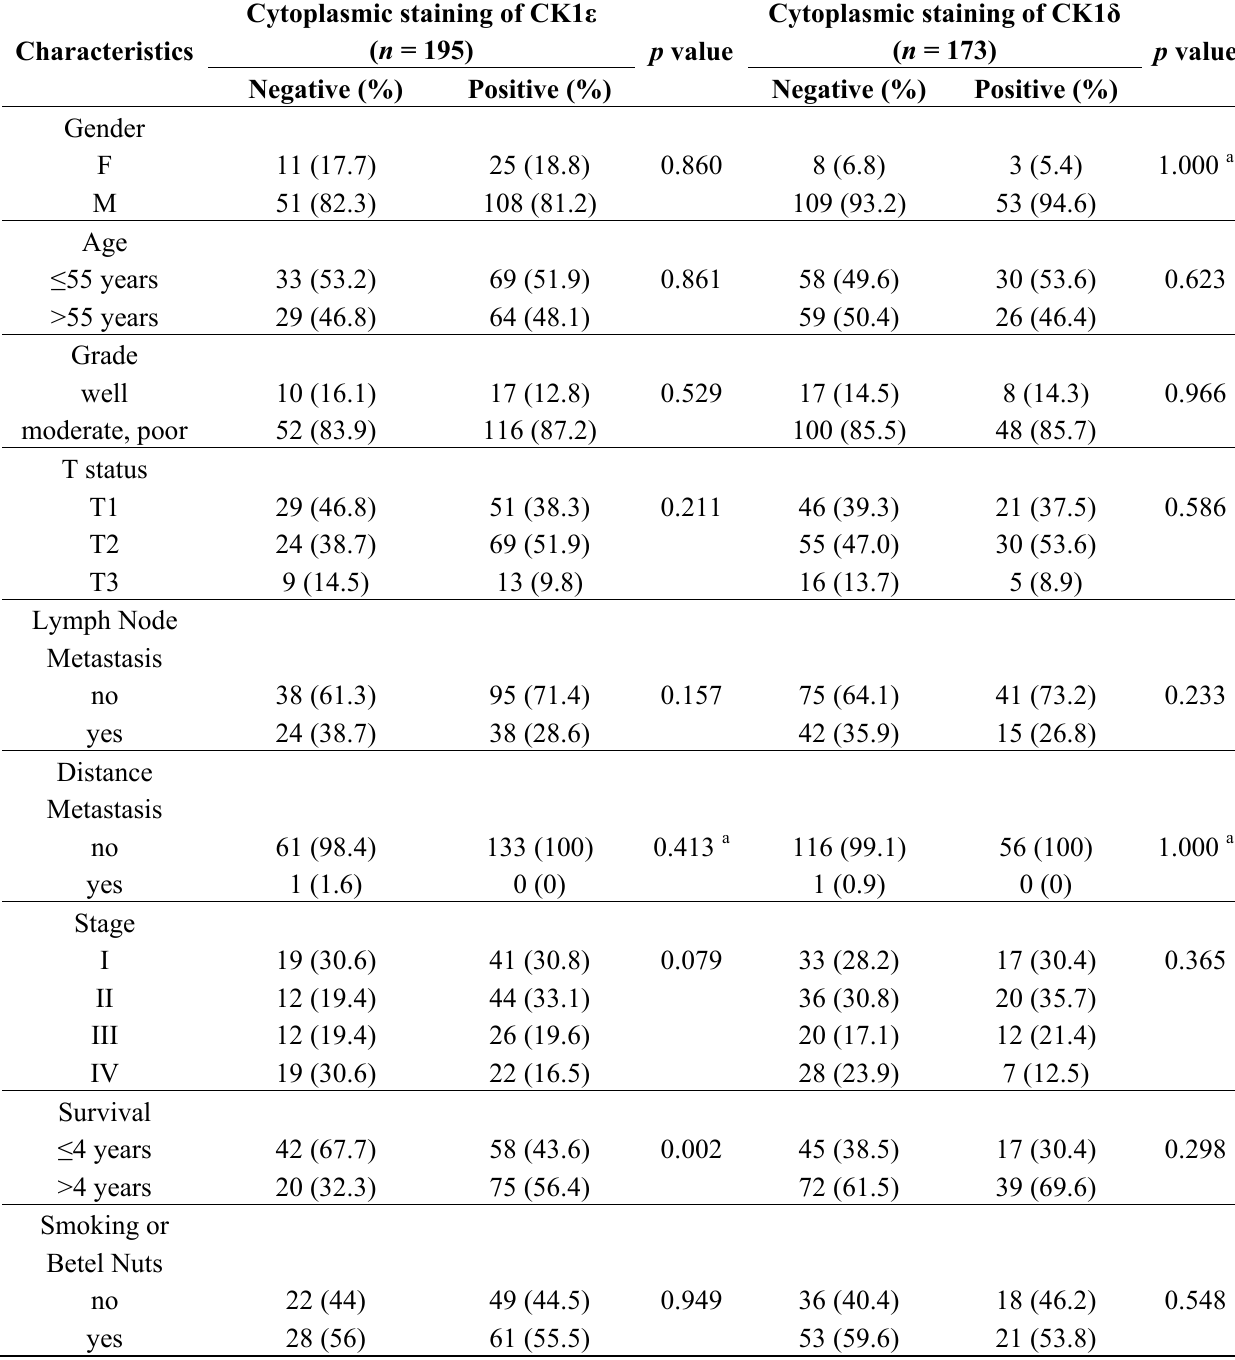
Table 2. Correlation of CK1ε expression with clinicopathologic indicators of oral cancer.